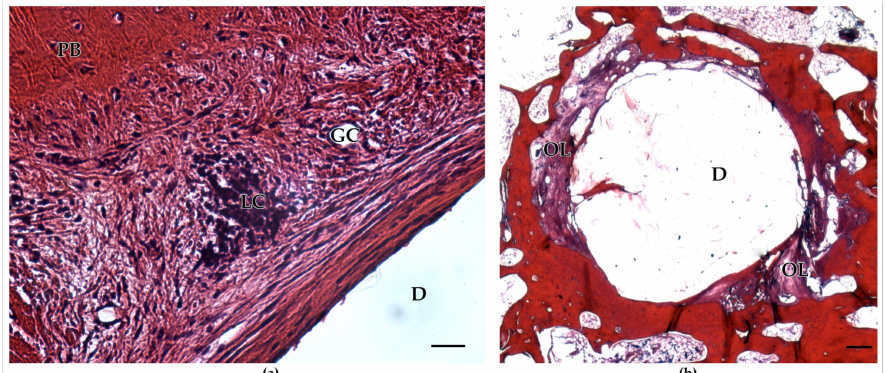
Figure 3. Histological sections of implanted BioM2: ( a ) surrounding tissue shows infiltration by lymphocytes (LC) and giant cells (GC) (left image). Peripheral bone (PB) is present in the left upper corner of the defect site (D). Scale bar 50 µ m; ( b ) osteolytic zones (OL) filled with fibrous tissue and inflammatory signs are present in the interface regions. Scale bar 1000 µ